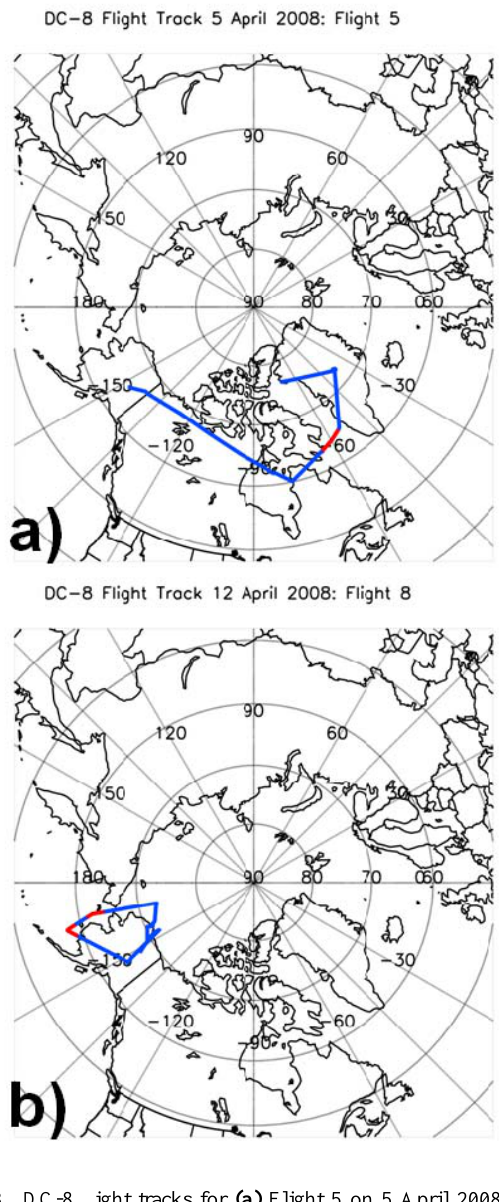
Fig. 3. DC-8 flight tracks for (a) Flight 5 on 5 April 2008, and (b) Flight 8 on 12 April 2008. Trajectories were released at 1 min intervals along the red segments.